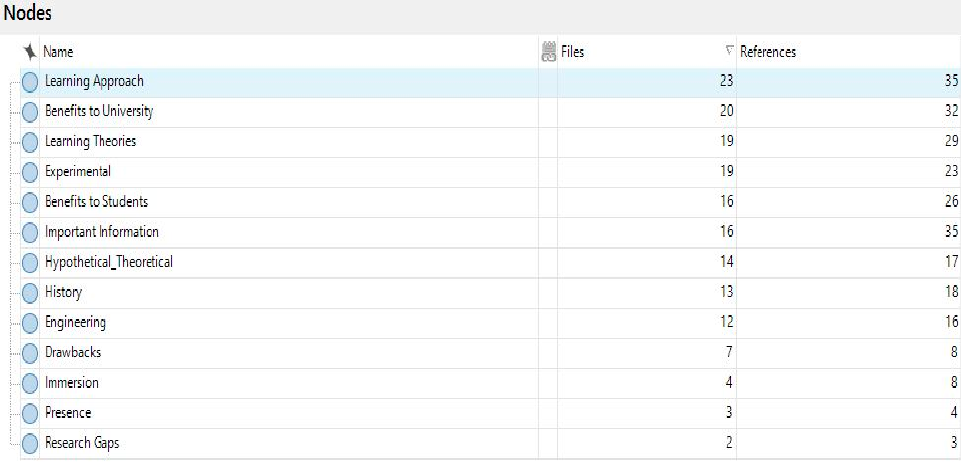
Figure 1. Nodal coding in Nvivo Software.